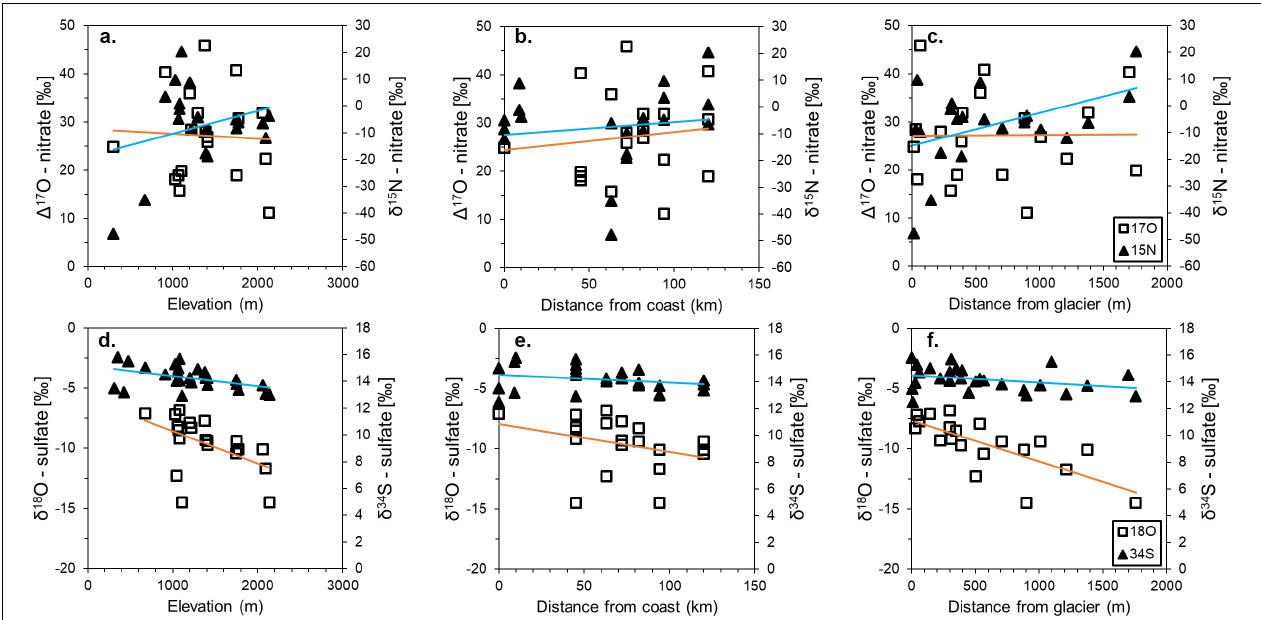
FIGURE 3 | Stable isotope values of δ 15 N and (cid:49) 17 O in nitrate (a–c) and δ 34 S and δ 18 O in sulfate (d–f) with elevation, distance from the coast of the Ross Ice Shelf, and distance from the nearest glacier. Blue lines are trend lines for δ 15 N and δ 34 S, while orange lines are trend lines for (cid:49) 17 O and δ 18 O.